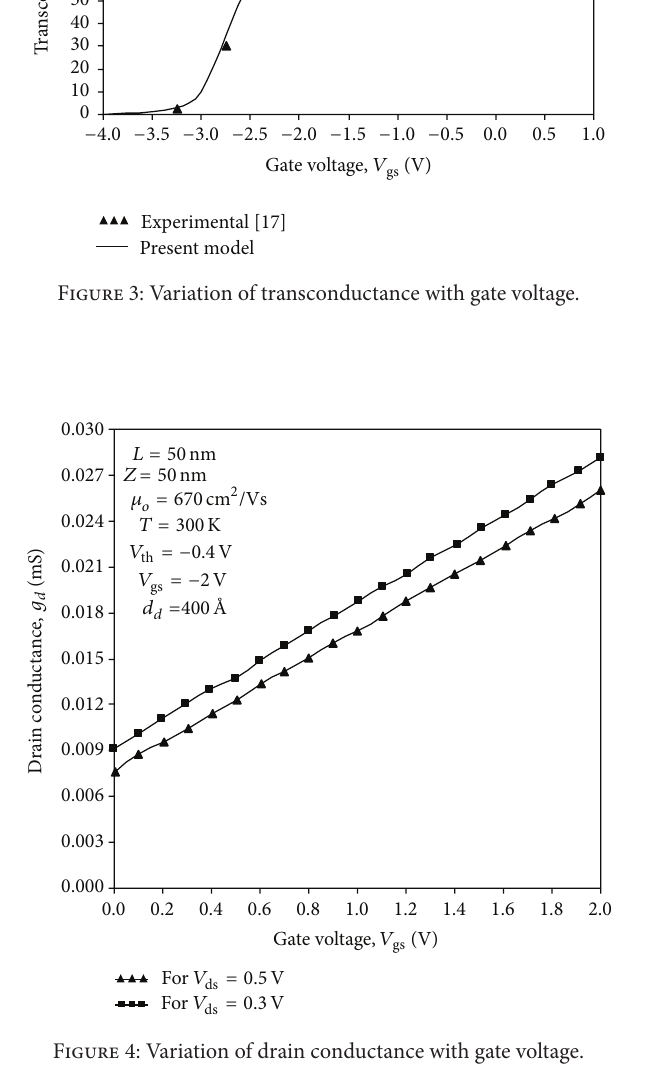
Figure 4: Variation of drain conductance with gate voltage.